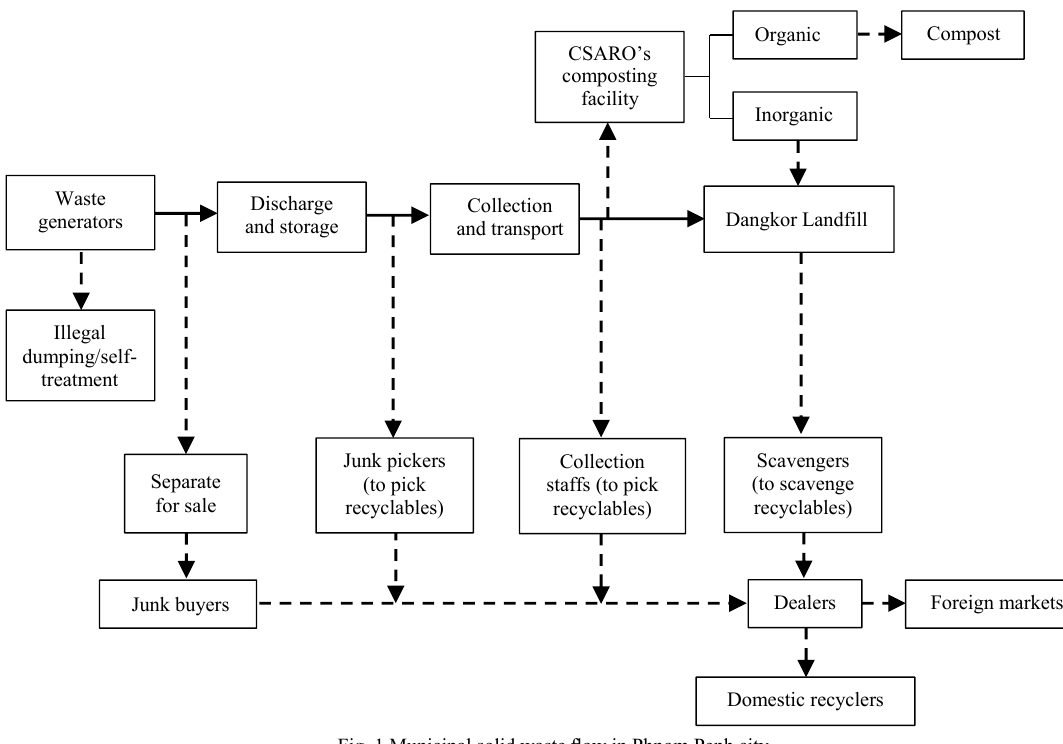
Fig. 1 Municipal solid waste flow in Phnom Penh city (Seng et al., 2010; Sothun, 2012; CSARO,